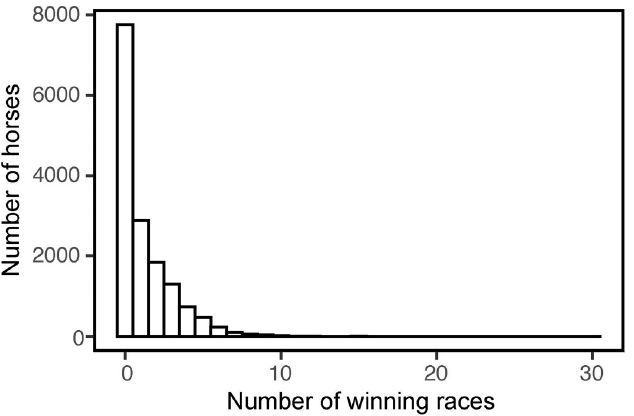
Fig 1. Relationship between the number of horses and the number of winning races (N = 15,461).